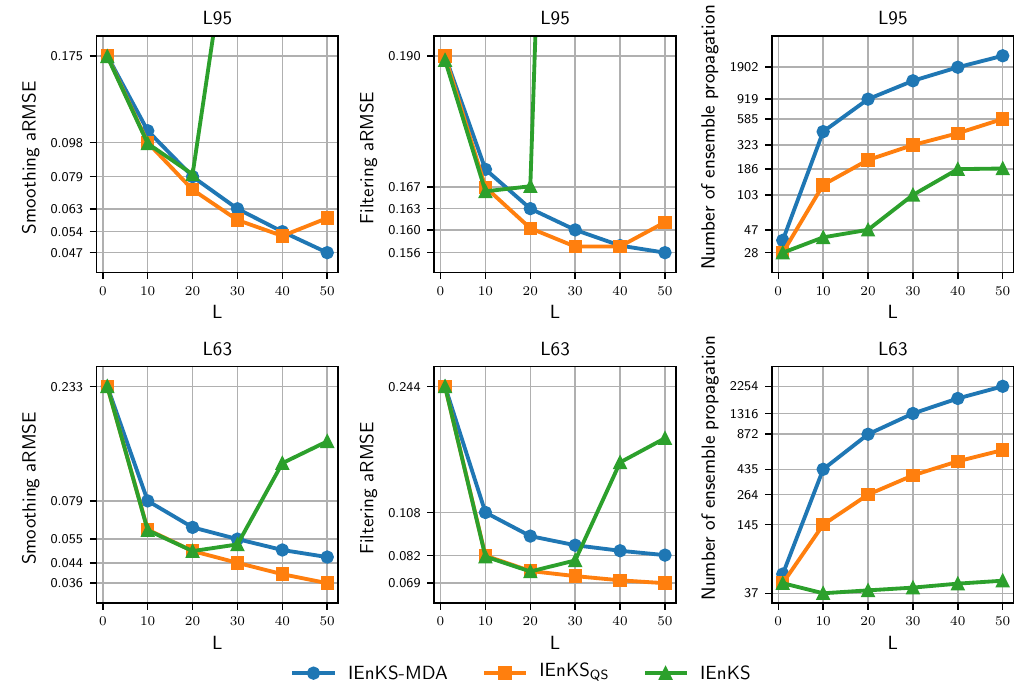
Figure 10. IEnKS-MDA ( S = 1), IEnKS QS and IEnKS ( S = L , N Q = S ) filtering and smoothing aRMSEs and number of ensemble propa- gations as a function of L for the L95 and L63 models (logarithmic scale). The ensemble propagations are in units of (cid:49)t . For instance, with L = 50, a single ensemble propagation through the DAW counts for 50.